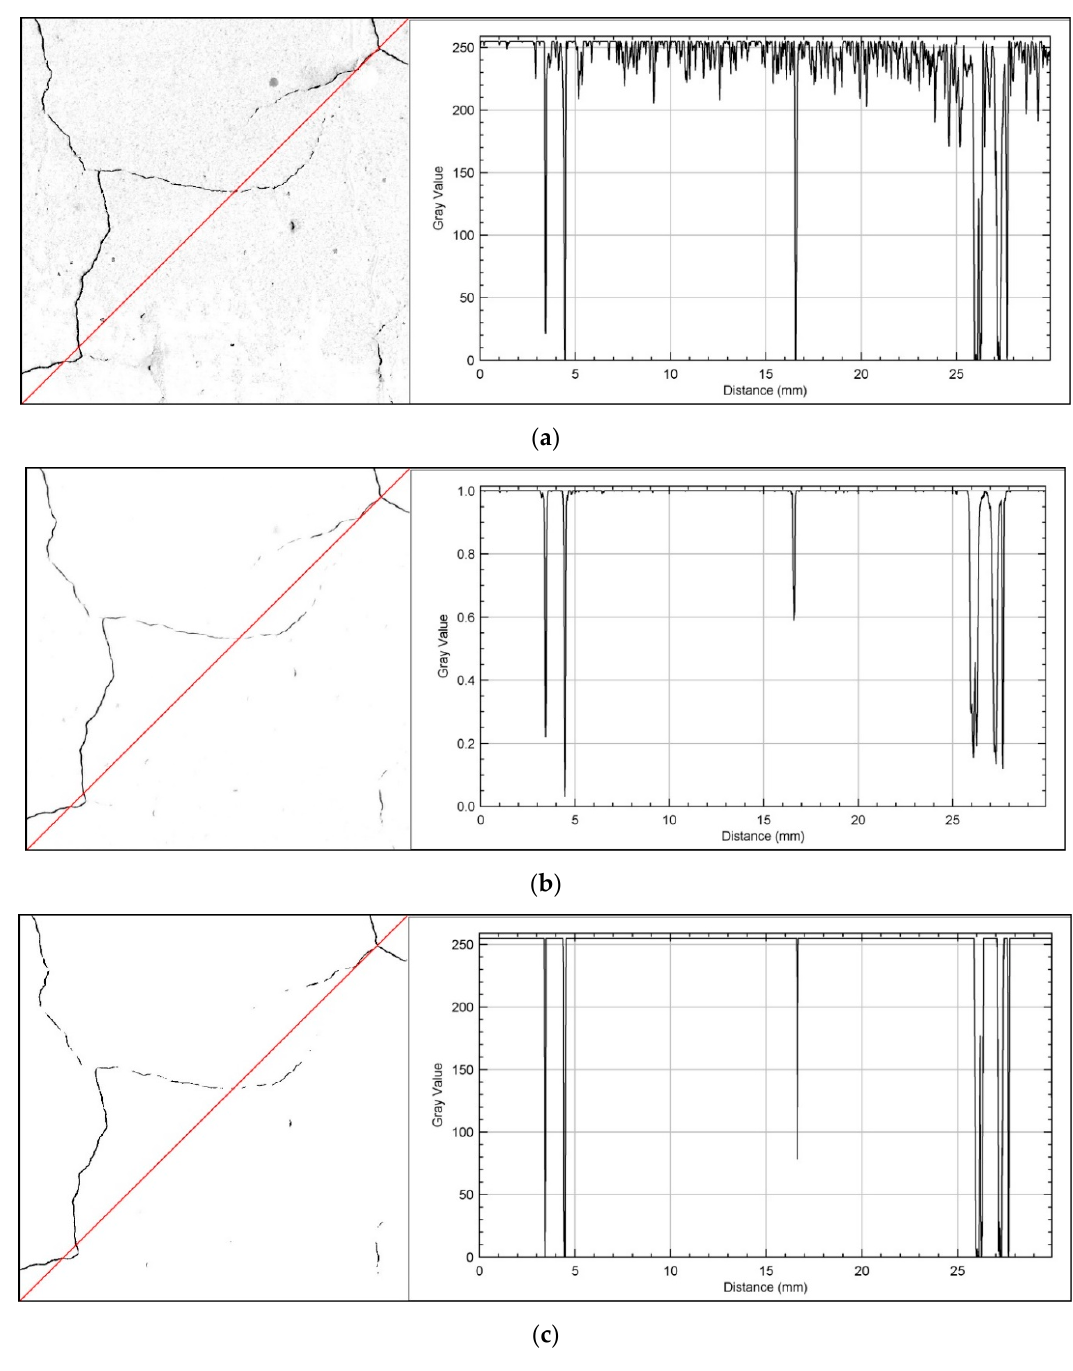
Figure 3. The surface of the pattern for CP32.5 series together with a plot profile showing the gradient value on the greyscale along the red line—the second segmentation stage: ( a ) input image; ( b ) probability map; ( c ) final image.